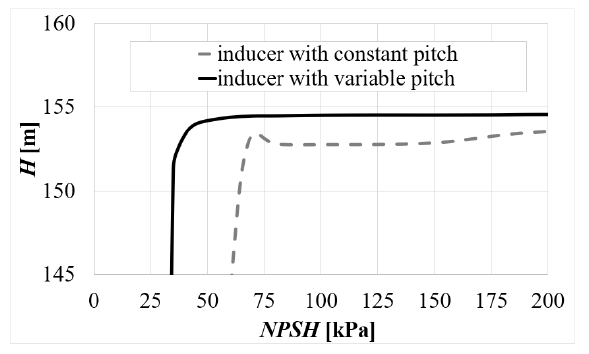
Fig. 11. Vapor volume fraction of value 0.1[3]